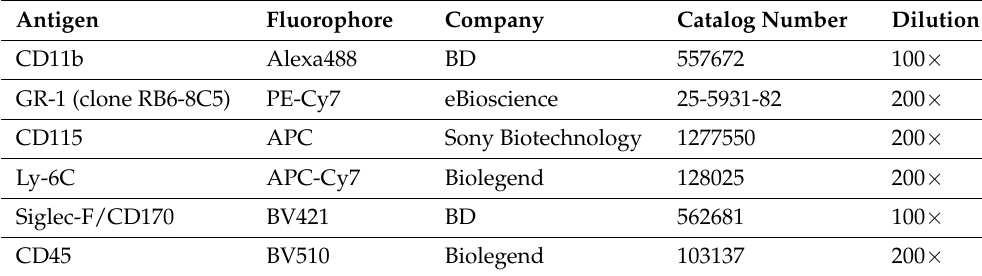
Table 2. Antibodies used to assess myeloid cell composition.